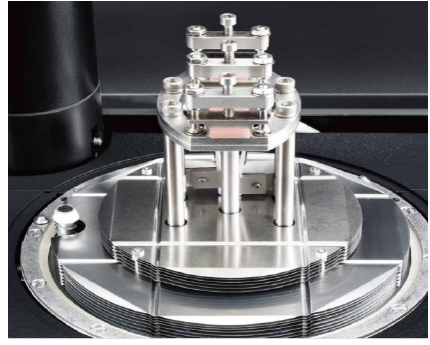
Figure 1. Double cantilever fixture.